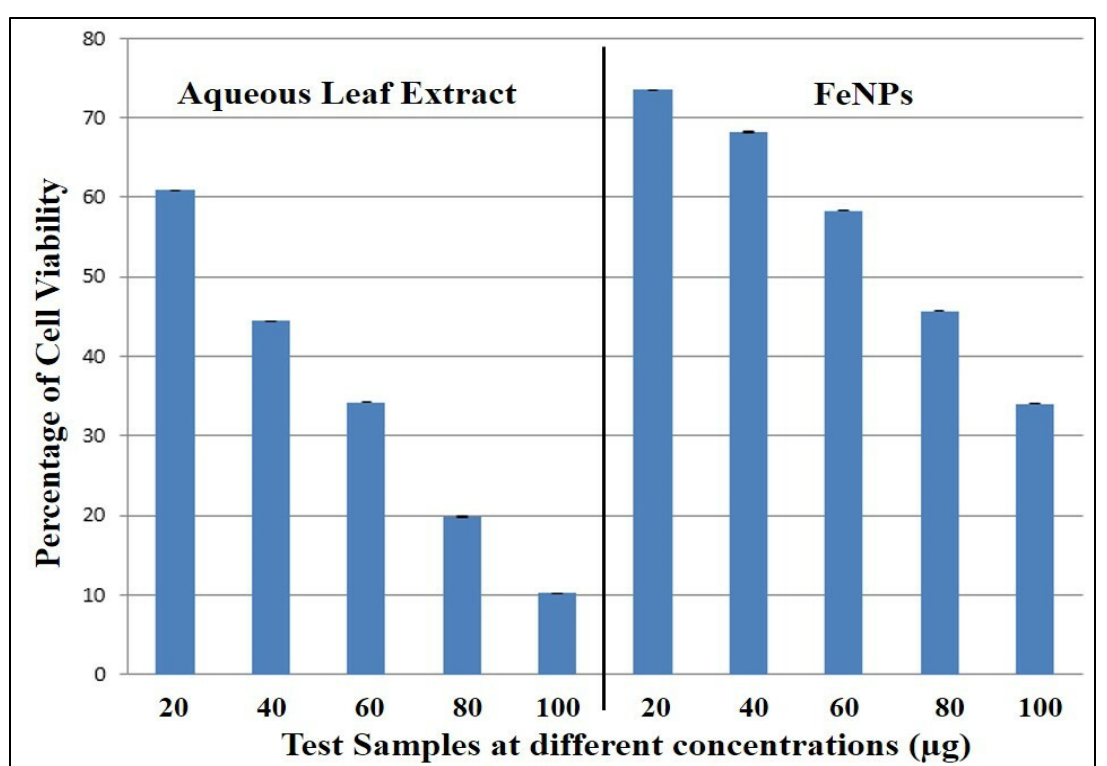
Figure 12. Percentage of cell viability of aqueous leaf extract of V. leucoxylon and its synthesized iron nanoparticles against L929 cell line.